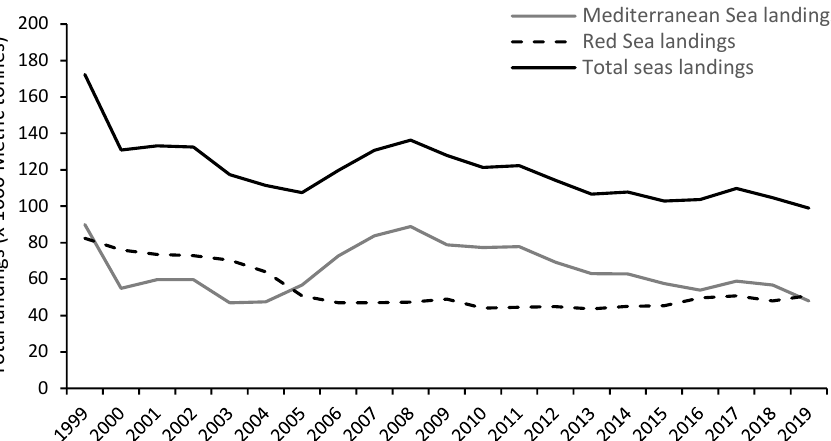
Figure 3. Evolution of total landings (x 1000 metric tonnes) in Egyptian marine fisheries, Egyptian Mediterranean Sea fisheries and Egyptian Red Sea fisheries in the last two decades (1999 – 2019).